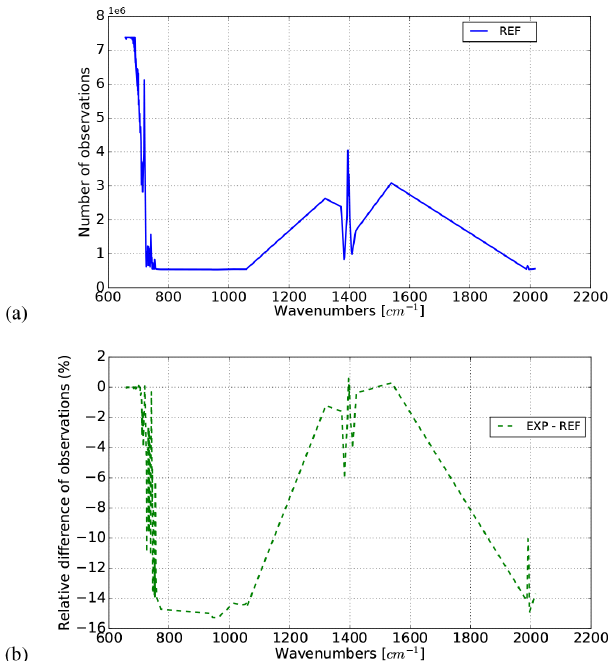
Figure 6. Number of assimilated IASI data over the whole exper- imental period (41d) as a function of wavenumber of IASI for the REF experiment (a) and relative difference of number of assimilated observations (b) for the EXP compared with REF (dashed green